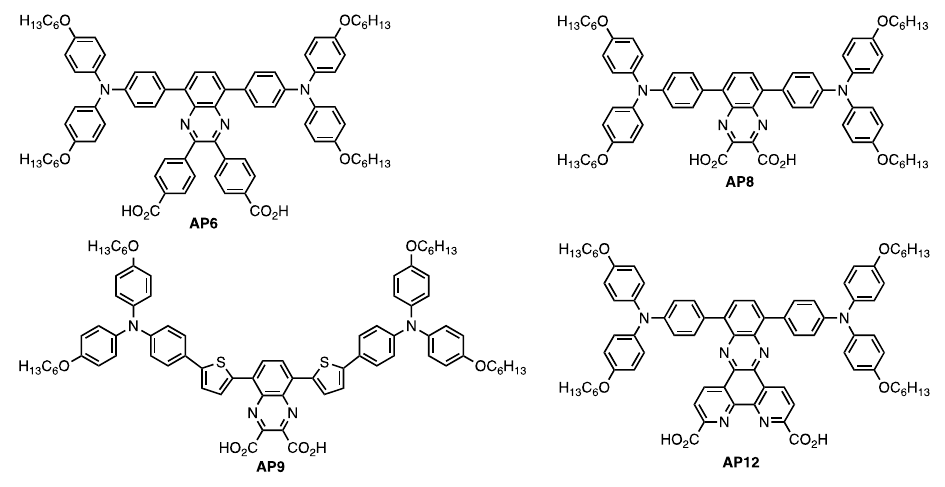
Figure 1. Target structures of AP6 , AP8 , AP9 , and AP12 .